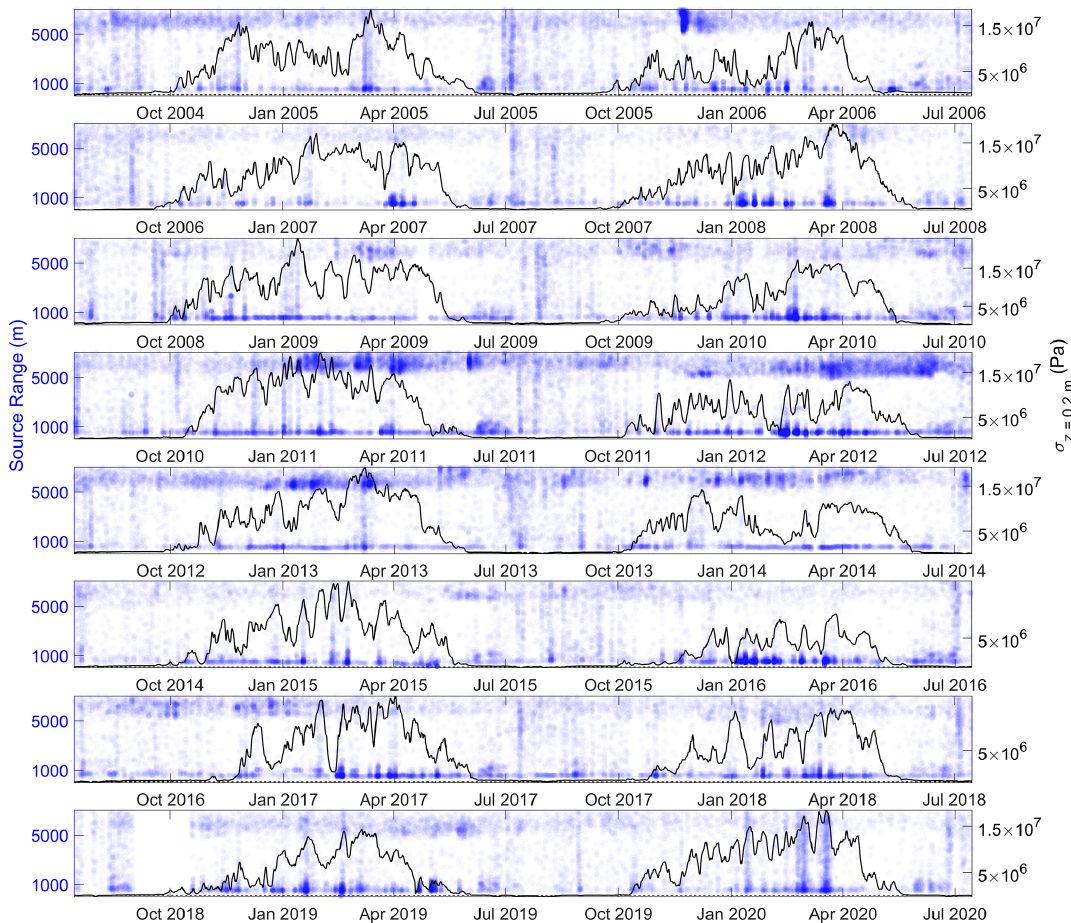
Figure 12. Modeled thermal stress from Eq. (12) at 0.2m depth (black lines) and ranges to coherent-MFP-localized sources (blue circles). Source ranges and azimuths are plotted as transparent points such that denser colors represent clusters of events. Event classes I and II are associated with small ( < 1500m) and large ( > 5000m) source ranges, respectively.